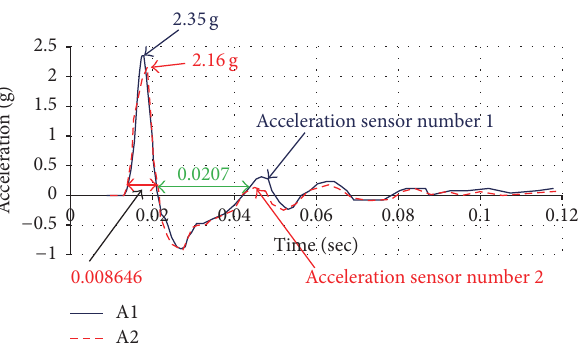
Figure 7: The acceleration-time graph for Explosion number 2. Figure 5: The acceleration-time graph for Explosion number 1. f = 968.7 Hz